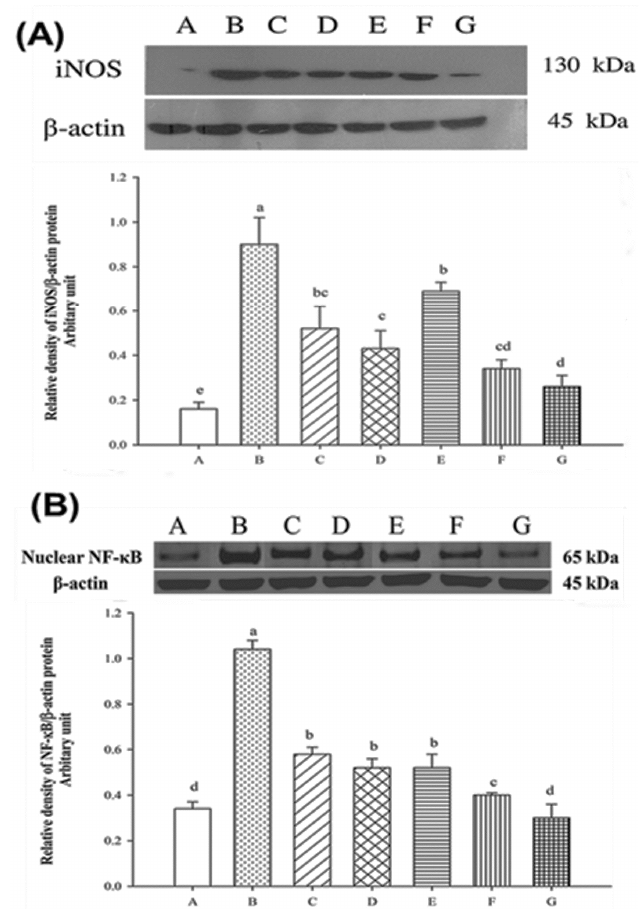
Figure 6. Expression of cytosolic iNOS ( A ) and nuclear NF- κ B ( B ) on rat hepatic tissues. A: Control group, B: LPS group, C: LPS + NAC 200 mg/kg, D: LPS + AST 10 mg/kg, E: LPS + LA 2 mg/kg, F: LPS + LA 5 mg/kg, G: LPS + LA 10 mg/kg. Densitometric analyses of proteins presented as the relative ratio of each protein to β -actin. Values are means ± SEM of three independent experiments. Different lower-case letters indicate statistically significant differences ( p < 0.05).